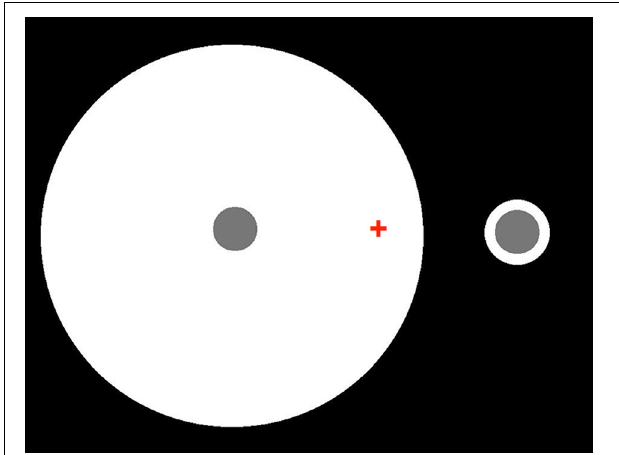
FIGURE 12 | Identical decremental disks seen in the context of annular surrounds having the same luminance but different widths. Fixate on the red cross. The left disk should appear darker than the right disk, even though they have the same luminance. Edge integration theory accounts for the different disk lightnesses by asserting that the disk lightness is computed from a weighted sum of the directed steps in log luminance at the disk/annulus and annulus/background borders. Thus, the disk lightness does not just depend on luminance or local contrast, but on a computation that is carried out over an extended region of the scene. Because luminance step at the disk/annulus border decreases in the direction of the disk, that border tends to darken the disk appearance. Because luminance step at the disk/annulus border increases in the direction of the disk, that border tends to lighten the disk appearance. The quantitative contribution of the disk/annulus border to the total disk lightness is the same for the two disks because the size and direction of the luminance step is the same in the two cases, and the border is in the same location relative to the disk center. The quantitative contribution of the annulus/background border to the total disk lightness is smaller in the case of the large annulus because the annulus background edge is further from the disk in that case, even though the luminance steps have the same magnitude and